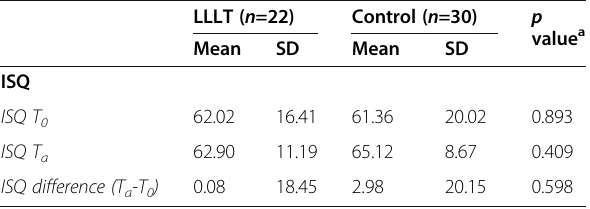
Table 2 Implant stability compared between LLLT and control groups